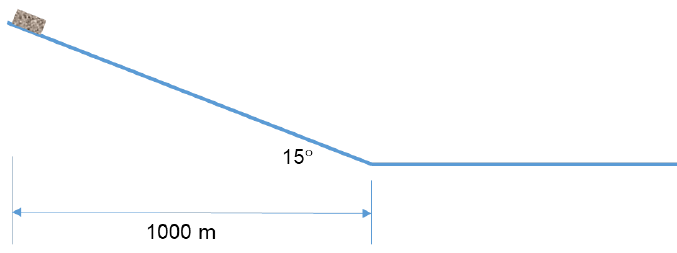
Figure 2. Geometry of the modeled